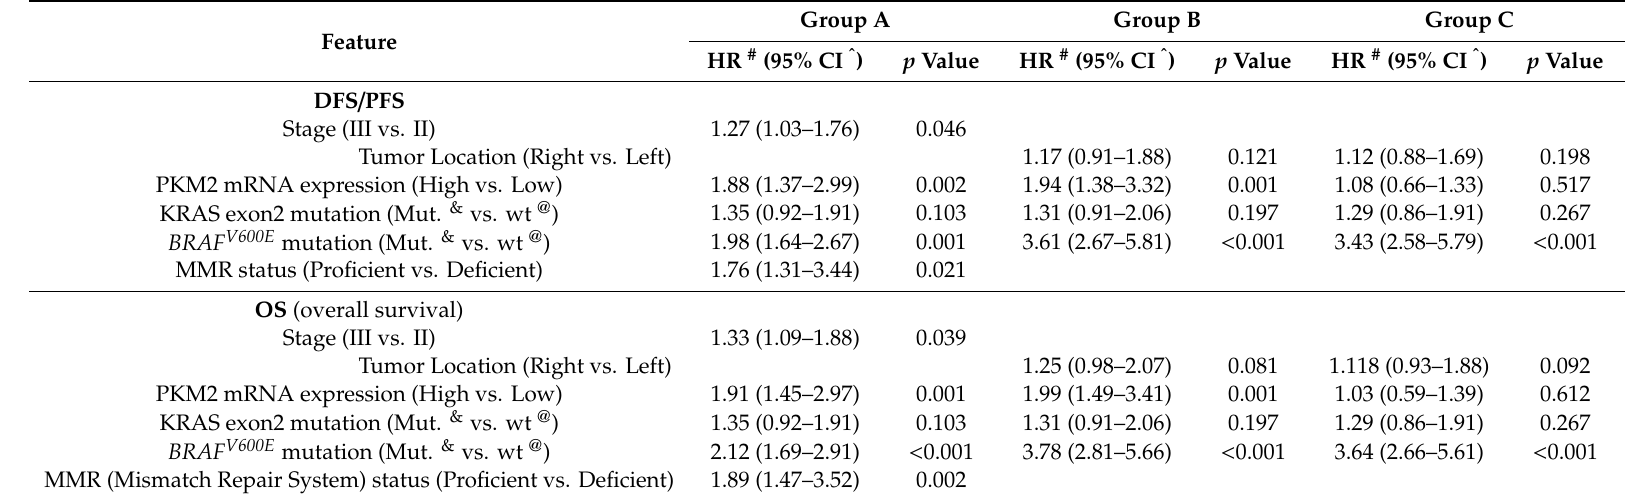
Table 4. Multivariate analysis for disease free survival (DFS, group-A), progression free survival (PFS, groups B and C), and median overall